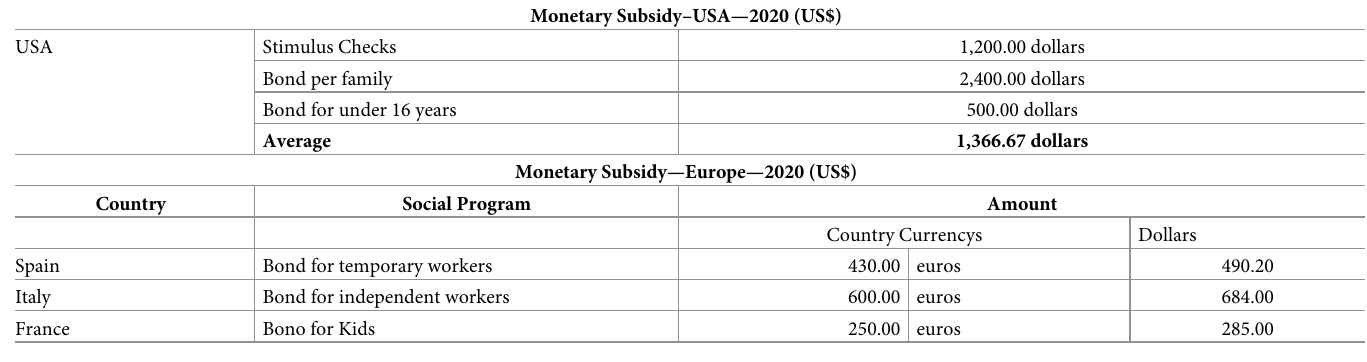
Table 1. Monetary subsidy in US and